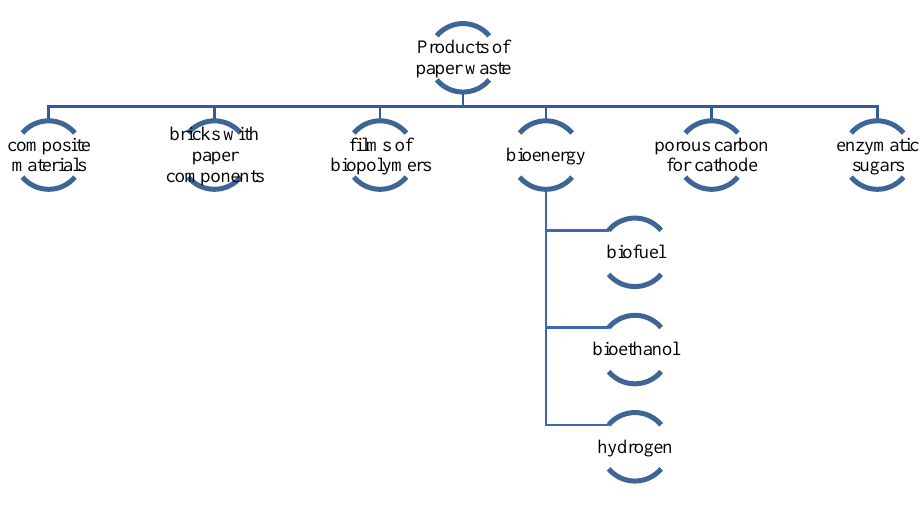
Fig. 1. Products from paper